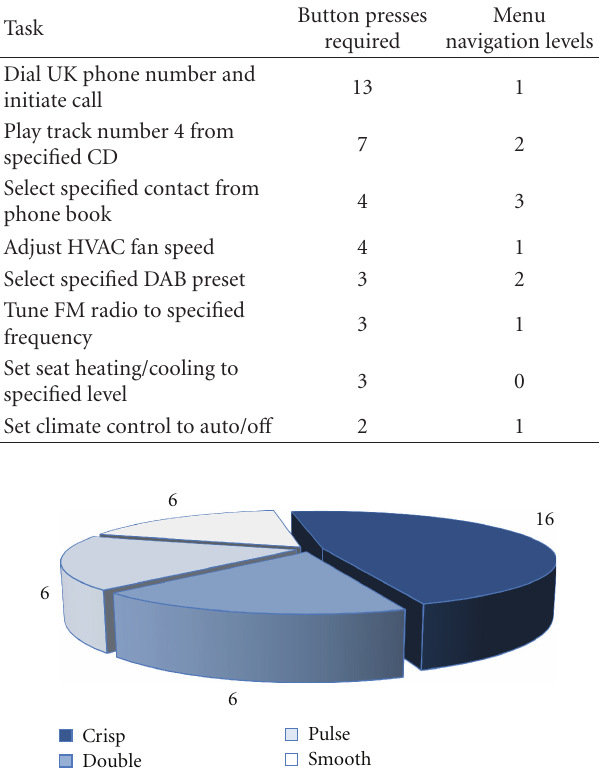
Table 2: Touchscreen use cases.